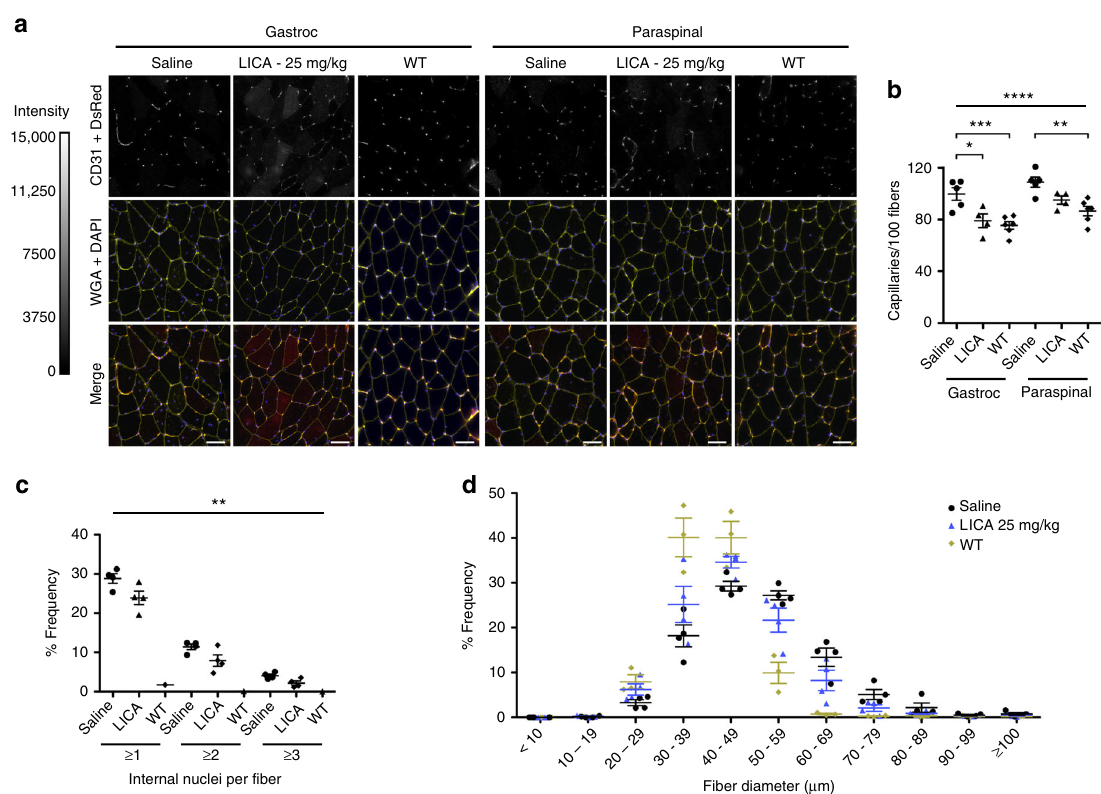
Fig. 9 LICA oligonucleotide treatment effects. a We examined capillary density in TR;HSA LR mice treated with saline ( N = 5) or LICA oligonucleotide 992948 (25 mg/kg twice weekly for 4 weeks; N = 4) by immunolabeling using an anti-CD31 antibody. Untreated FVB wild-type (WT) mice ( N = 6) served as controls. Shown are representative images of gastrocnemius muscle cryosections. Muscle fi bers are highlighted with Alexa 647-wheat germ agglutinin (WGA; pseudocolored yellow) and nuclei with DAPI (blue). Merge DsRed (red) + GFP (green) + WGA + DAPI. Fluorescence images are the extended focus of deconvolved Z-series. Intensity scale = 0 – 15,000 grayscale units (CD31). Bars = 50 μ m. b Quantitation of capillary density, as measured by the number of capillaries per 100 gastrocnemius or paraspinal muscle fi bers, in TR;HSA LR mice treated with saline or LICA oligo, and untreated WT controls. Error bars indicate mean ± s.e.m. **** P < 0.0001, overall difference between saline-treated, LICA-treated, and WT groups; *** P < 0.001 (gastrocnemius, saline-treated vs. WT); ** P < 0.01 (paraspinal, saline-treated vs. WT), and P = 0.0012, (overall difference between gastrocnemius and paraspinal); * P < 0.05 (gastrocnemius, saline-treated vs. LICA-treated); two-way ANOVA. c Quantitation of internal nuclei frequency in the saline-treated, LICA-treated, and WT groups. Error bars indicate mean ± s.e.m. ** P = 0.0015 saline vs. treated group; two-way ANOVA. d Minimum Feret ’ s diameter, de fi ned as the minimum distance between parallel tangents 62 , of gastrocnemius muscle fi bers of TR mice treated with saline (black circles) or the LICA oligo (blue triangles), and untreated wild-type (WT) controls (yellow diamonds). Error bars indicate mean ±